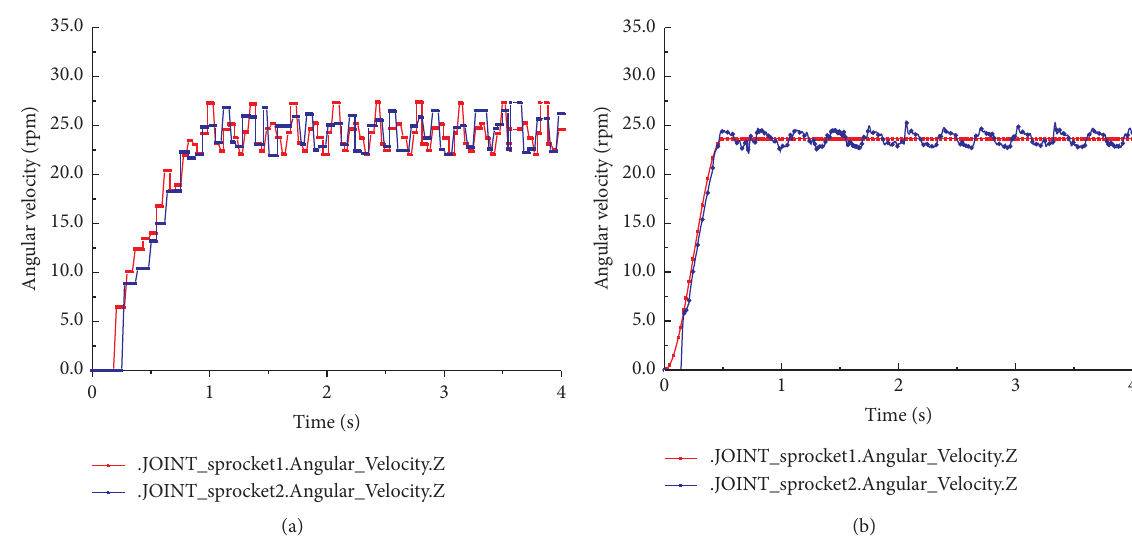
Figure 4: Sprocket rotational speed comparison. (a) Experimental data. (b) Simulation data. Table 2: Comparison of the test and simulation